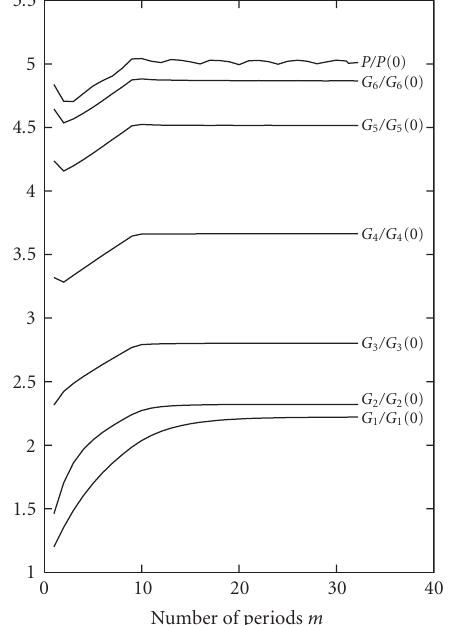
Figure 8: Saturation trend for precursors and system power when including feedback e ff ects in the evaluation of a periodic reactivity insertion. Feedback coe ffi cient α = 1 . 53 pcm/ ◦ C. The maximum values of power and delayed amplitudes over each oscillation are plotted as functions of the number of periods m .